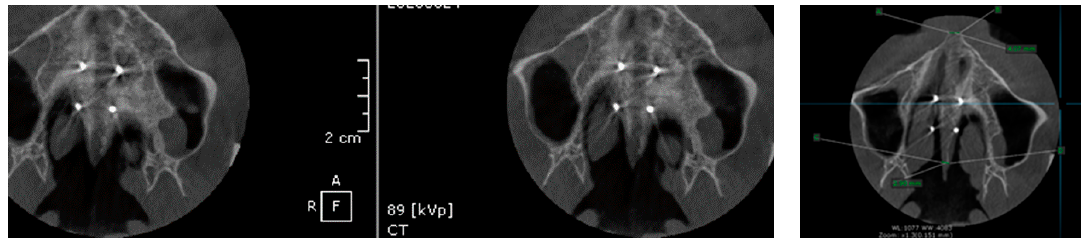
Figure 7. Rendering images showing cortico-puncture perforations and micro-implants in position.